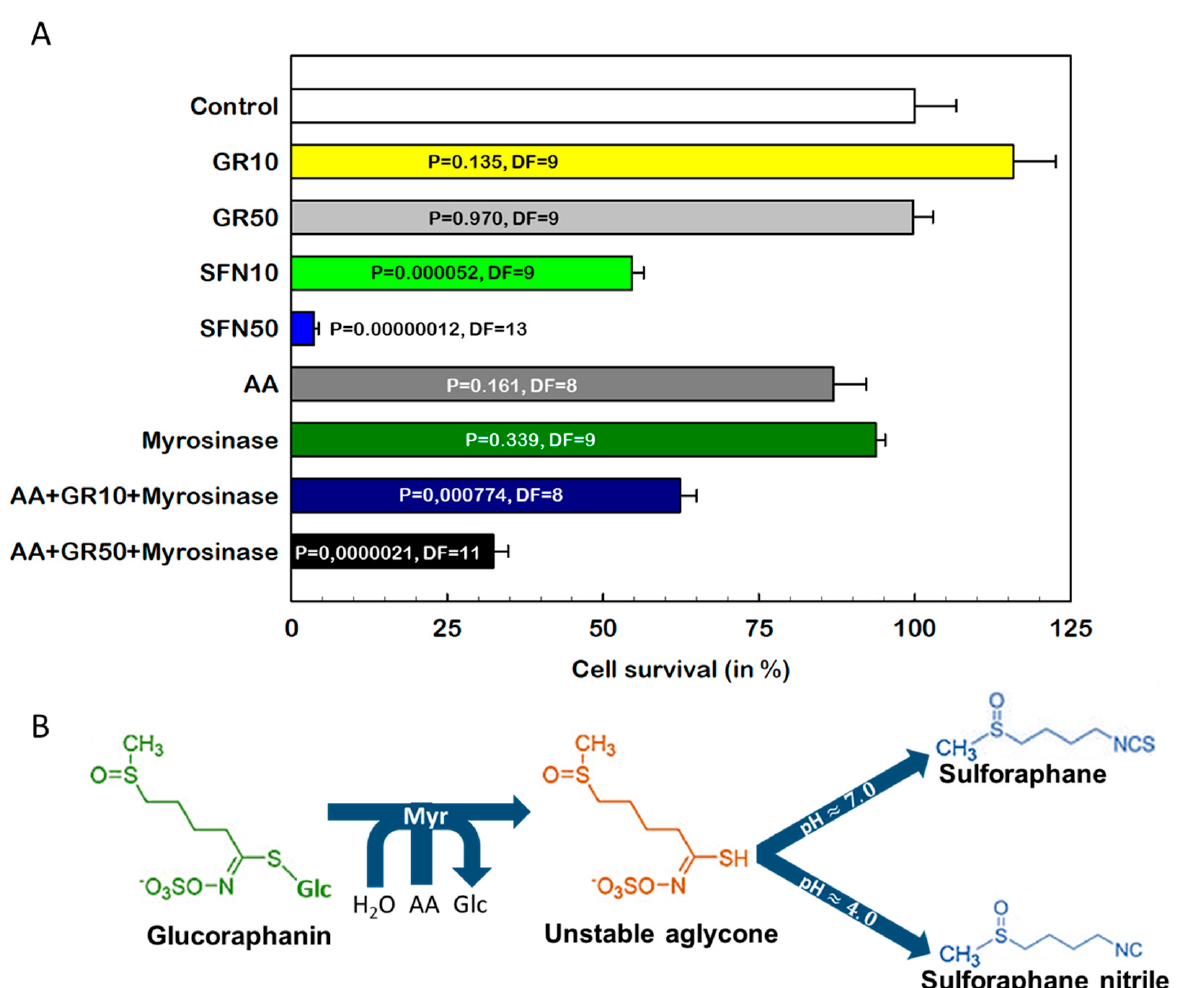
Figure 1. Comparison of sulforaphane (SFN) and glucoraphanin (GR) in the induction of S-cell death. Glc, glucose; Myr, myrosinase; AA, ascorbic acid. ( Panel A ) Cell death induced by SFN and GR alone or in combination with Myr and AA in S cells. S cells were cultured under standard conditions with either GR (10 µ M and 50 µ M), SFN (10 and 50 µ M), AA (10 µ M) and recombinant Myr, each alone, or with GR in combination with Myr and AA at the same concentration. After incubation of cells, the MTT assay was used to estimate cell viability. The results represent the mean values ± SD. Changes were considered significant when p < 0.05. ( Panel B ) Scheme of GR activation by the myrosinase reaction.